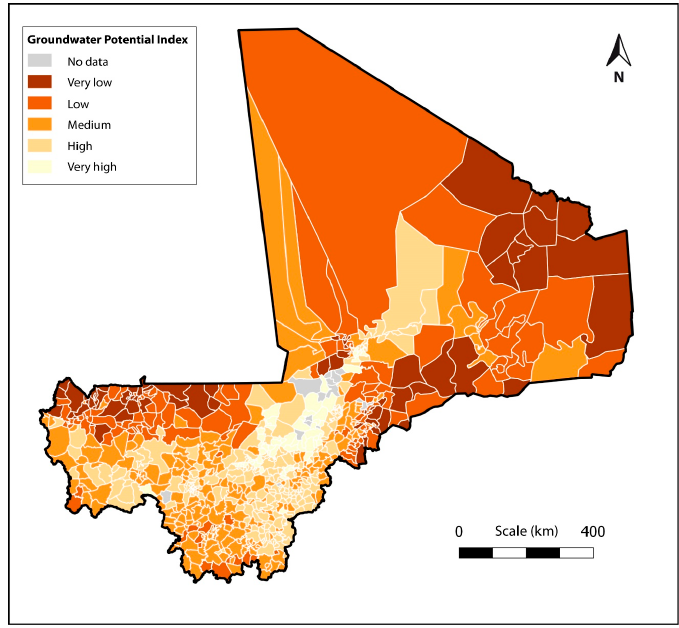
Figure 7. National-scale groundwater potential index. Data aggregated at the commune scale. Communes in gray are those where data were not available for at least one of the borehole-related variables.